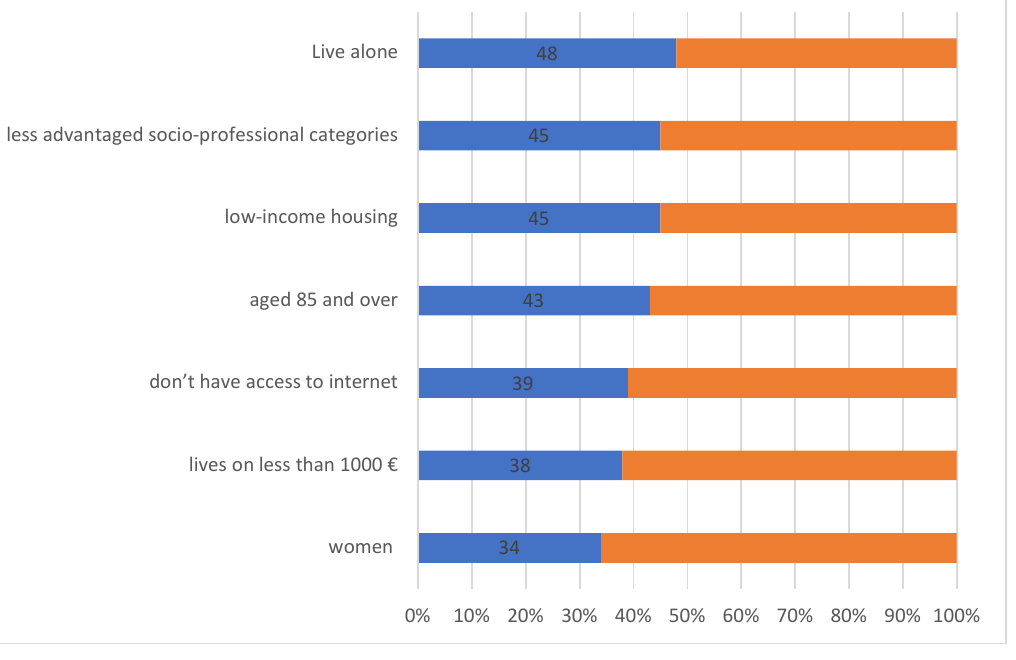
Table 3. Territories, solitudes; summary of key figures by territory [35].